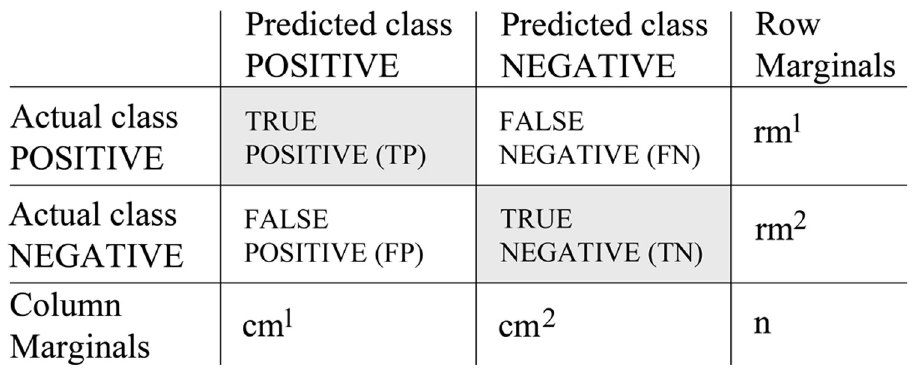
Fig 4. Random forests confusion matrix according to van Rijsbergen